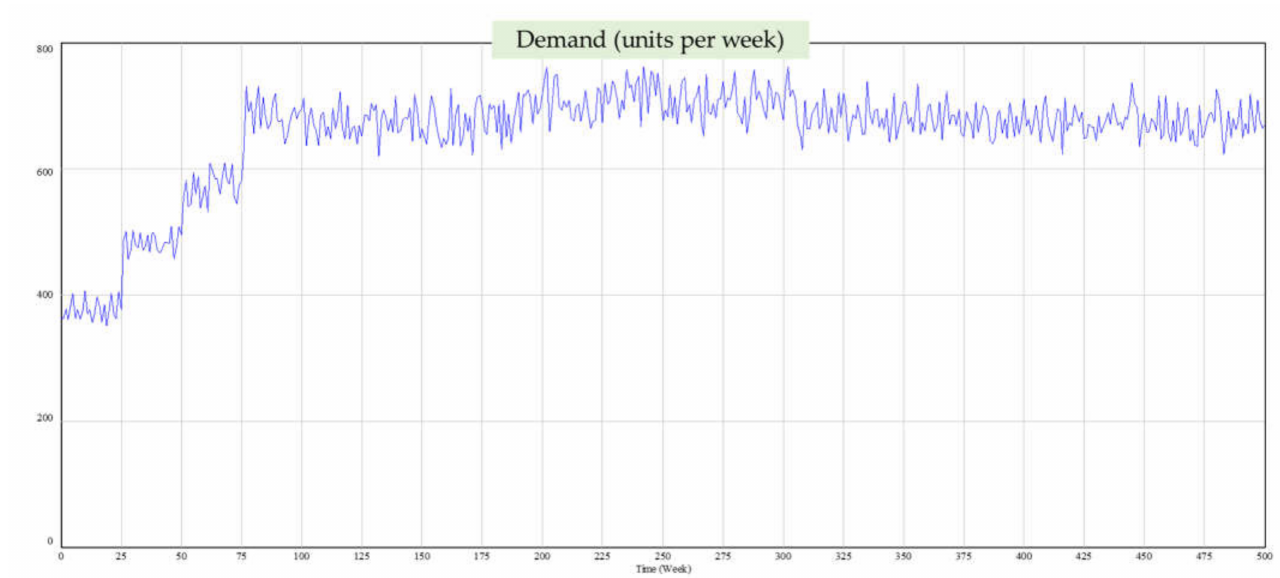
Figure 9. Demand level scenario for all simulation models (the authors’ own